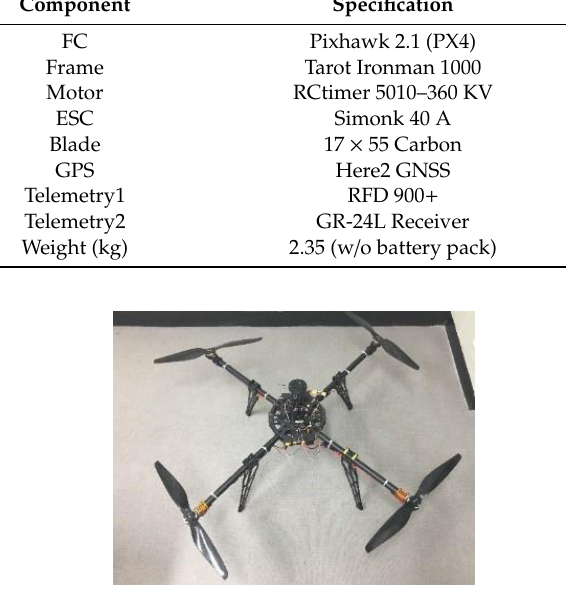
Figure 7. Overview of the UAV.